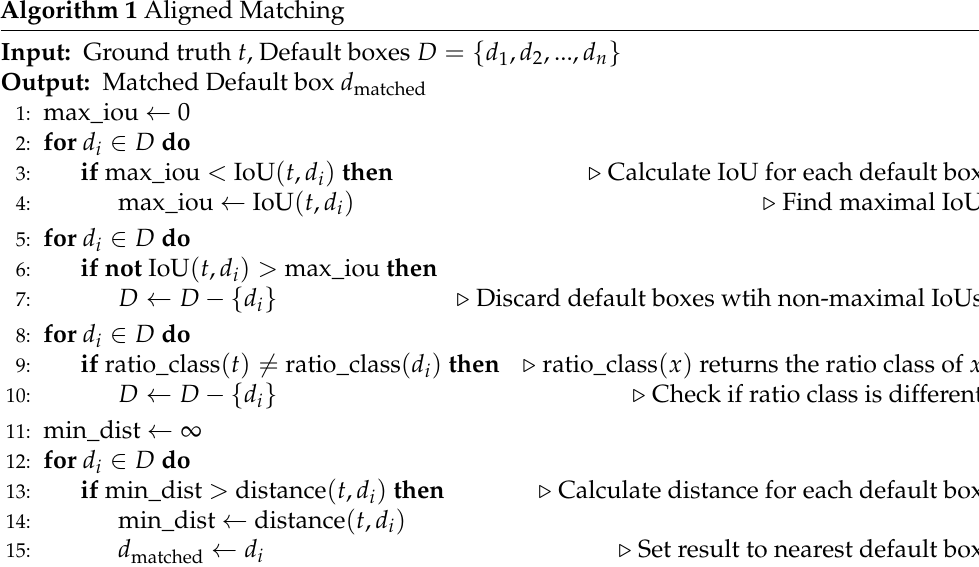
Algorithm 1 Aligned